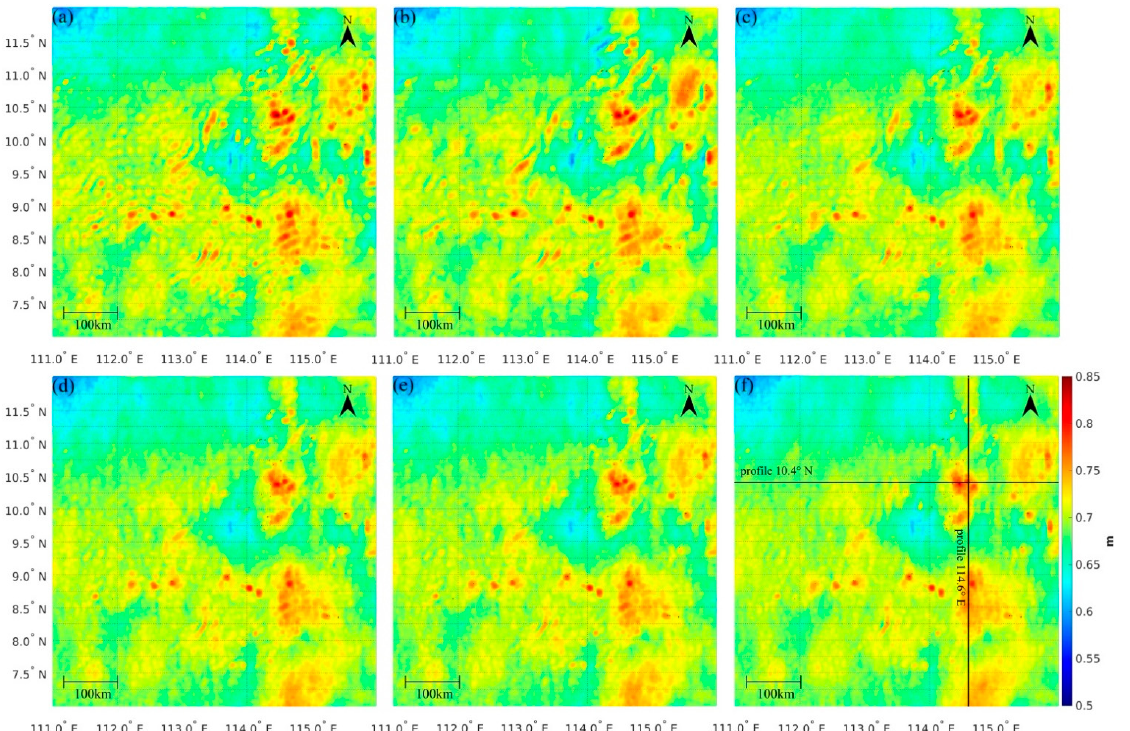
Figure 6. MDTs derived from the quasi-geoid model computed from ( a ) XGM2019e_2159, ( b ) HY2A, ( c ) SCSGA, ( d ) SIO30, ( e ) SIO31, and ( f ) DTU21GRA. The geographical coordinates are expressed in the Plate Carr é e projection. Note: only SIO30, SIO31, and DTU21GRA were computed with the SAR altimetry data derived from Sentinel-3A/B over the study